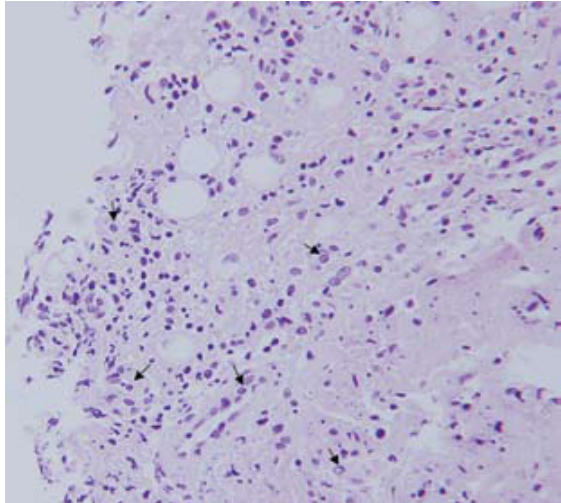
Fig. 2. Intracellular organisms with prominent outlines indicated by